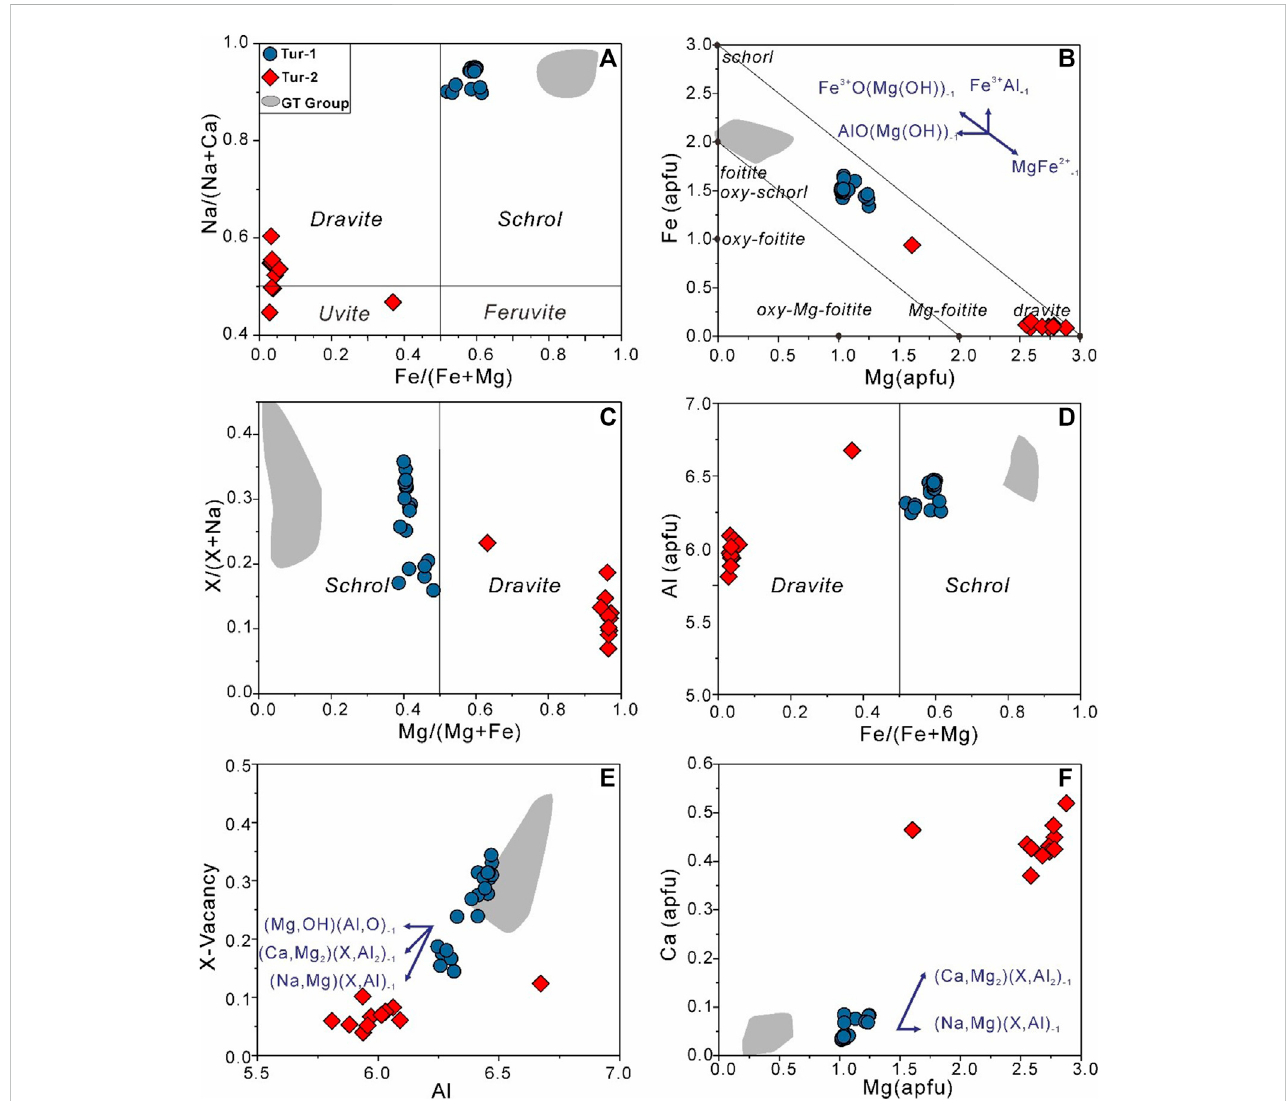
FIGURE 4 Diagrams for Tur-1 and Tur-2 in the hydrothermal vein and skarn from the Cuonadong Sn – W – Be polymetallic deposit, showing the chemical compositional evolution and classi fi cation of hydrothermal tourmaline. (A – D) Classi fi cation diagrams for tourmaline species; (E – F) plot of Al versus X-site vacanciesandMg versus Ca.ThetourmalinedataintheleucograniteintheXianglinareaintheCuonadongdome(GTgroup,grayarea)wereobtainedfromXie et al.